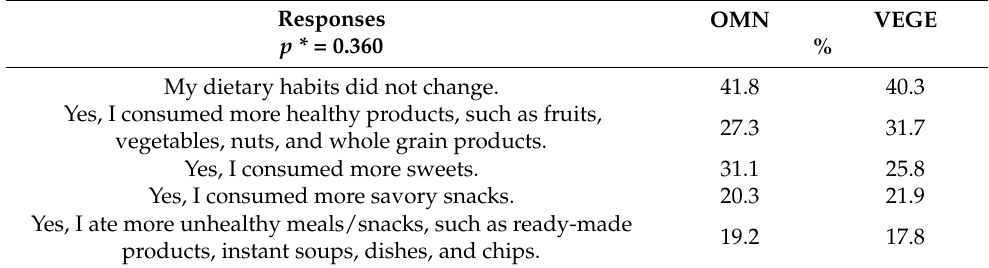
Table 9. Changes in eating habits among the study groups—the most frequently indicated answers.